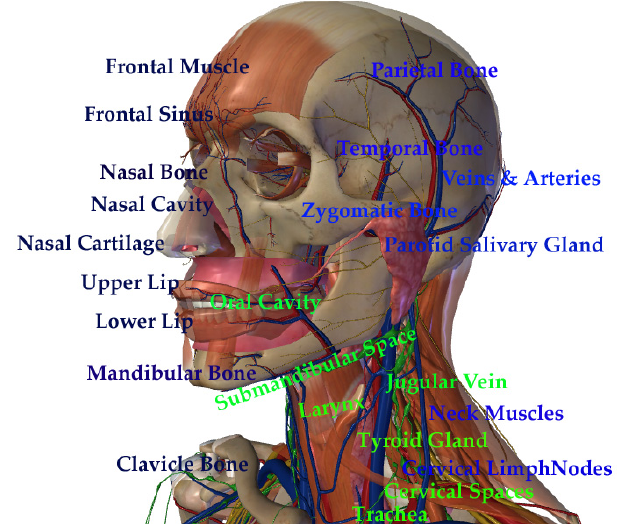
Figure 1. Schematic drawing of the head and neck anatomical sites (adapted from Zygote body 3D Anatomy).